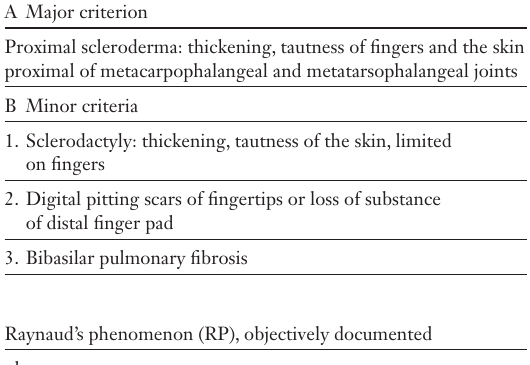
2001 LeRoy and Medsger proposed criteria for limited forms of SSc (lSSc)